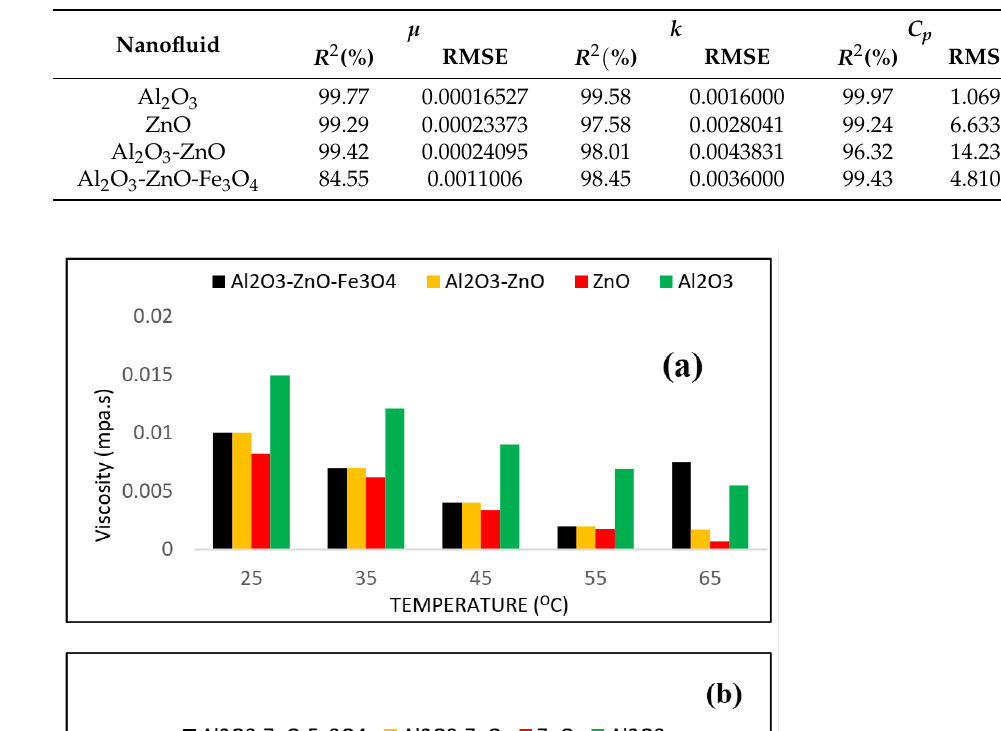
Table 2. Correlation coefficients and RMSE.